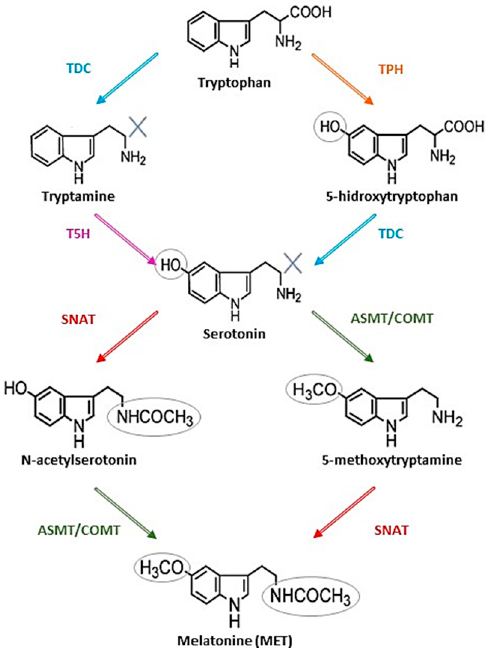
Figure 1. The four possible routes of melatonin (MET) biosynthesis. The enzymes that participate in the synthesis are: tryptophan decarboxylase (TDC), tryptophan hydroxylase (TPH), tryptamine 5-hydroxylase